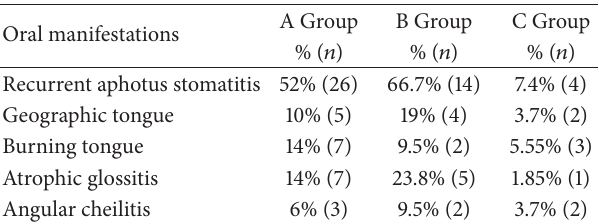
Table 1: Localization of the Oral soft tissue lesions and percentage on each group.